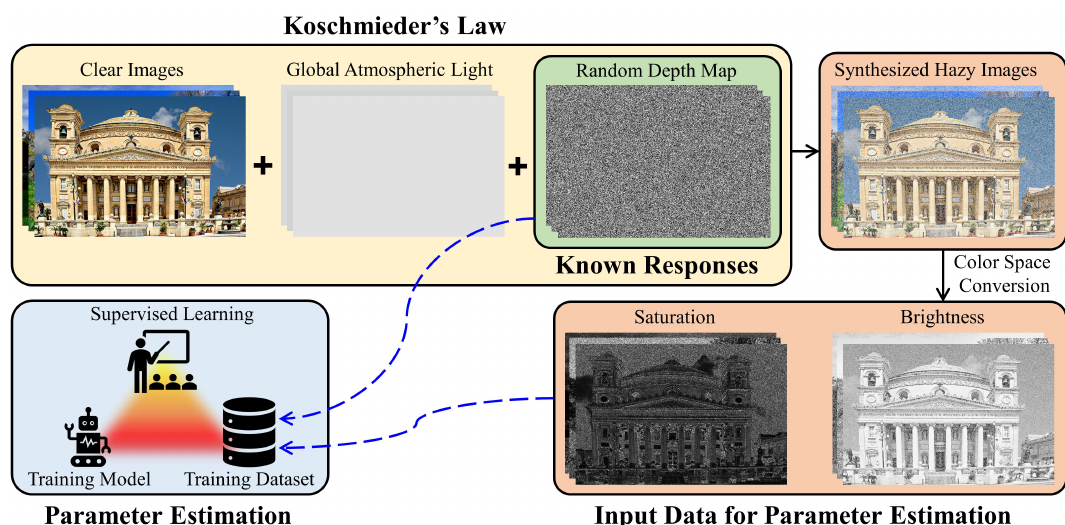
Figure 3. The procedure of preparing the synthetic training dataset for supervised learning-based parameter